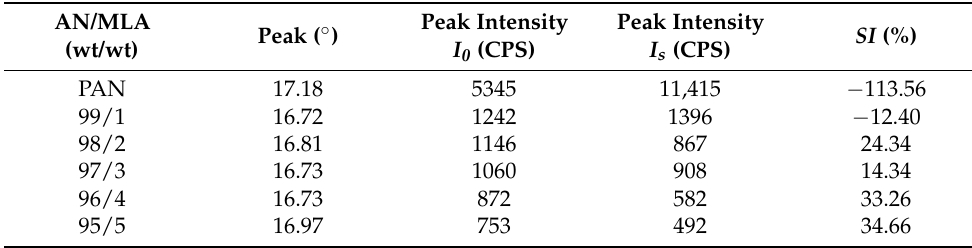
Table 4. SI results of P (AN- co- MLA) copolymers prepared with different compositions according to Figure 9.